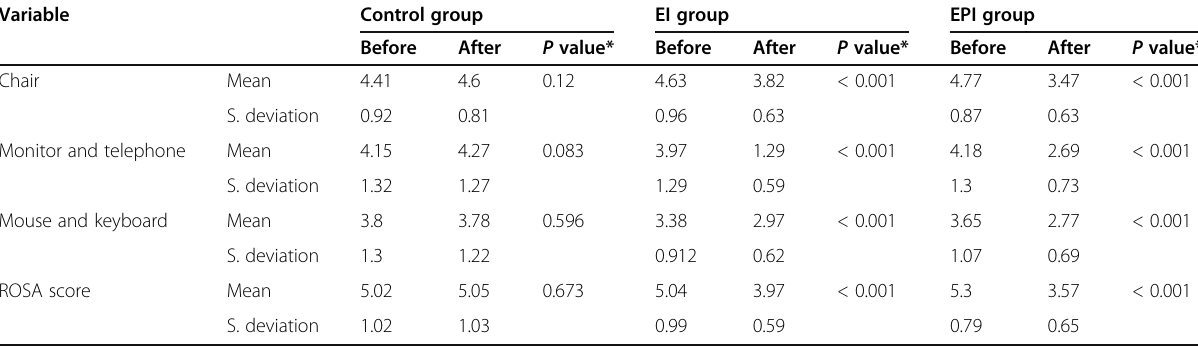
Table 2 Comparative results of mean ROSA score and its components in staff workstations of groups before and after intervention Variable Control group